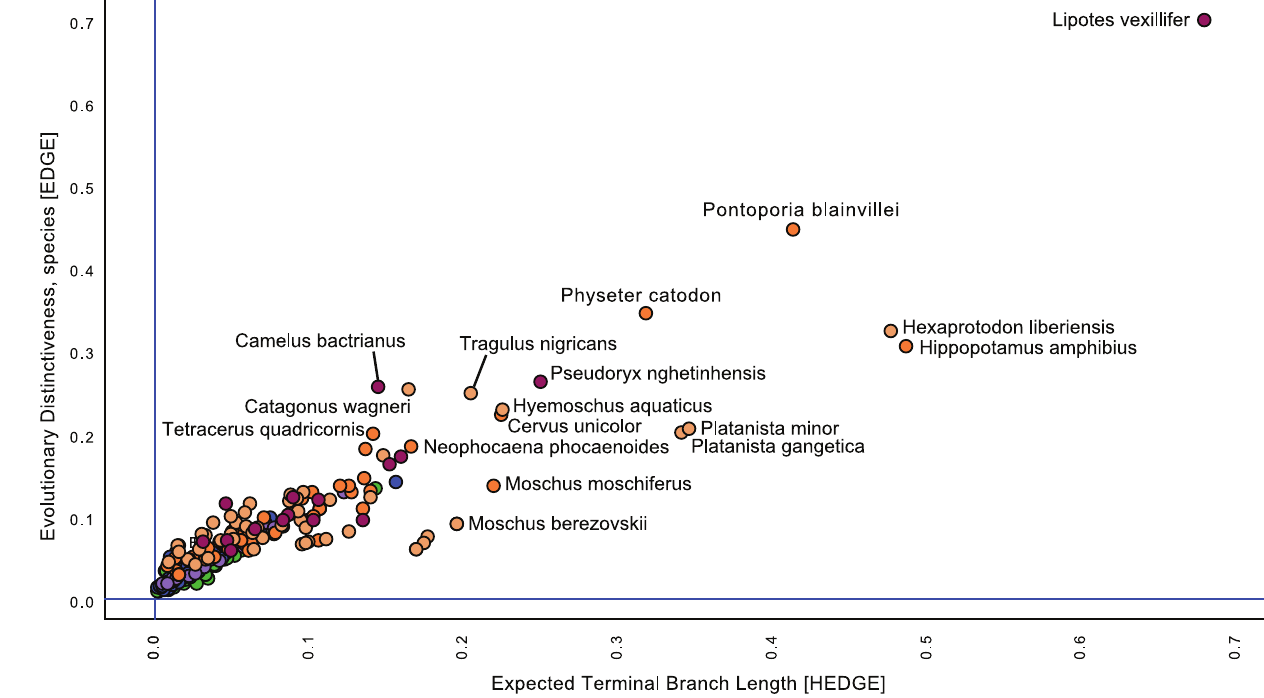
Figure 1. Conservation priorities based on the agreement between EDGE and HEDGE for Cetartiodactyla using the pessimistic transformation. (Red dots=Critically Endangered, Orange dots=Endangered, Yellow dots=Vulnerable, Dark Green dots=Least Concern, Light Green=Near Threat, Blue=Data Deficient). doi:10.1371/journal.pone.0022562.g001 simply as species shared among analyses in the top-30 list For species for which the Red List does not estimate extinction suggested by each method, and highlight top priority conserva- risk due to insufficient information (data deficient - DD), we tion species which all methods rank highly. arbitrarily assigned an extinction risk value in between the two